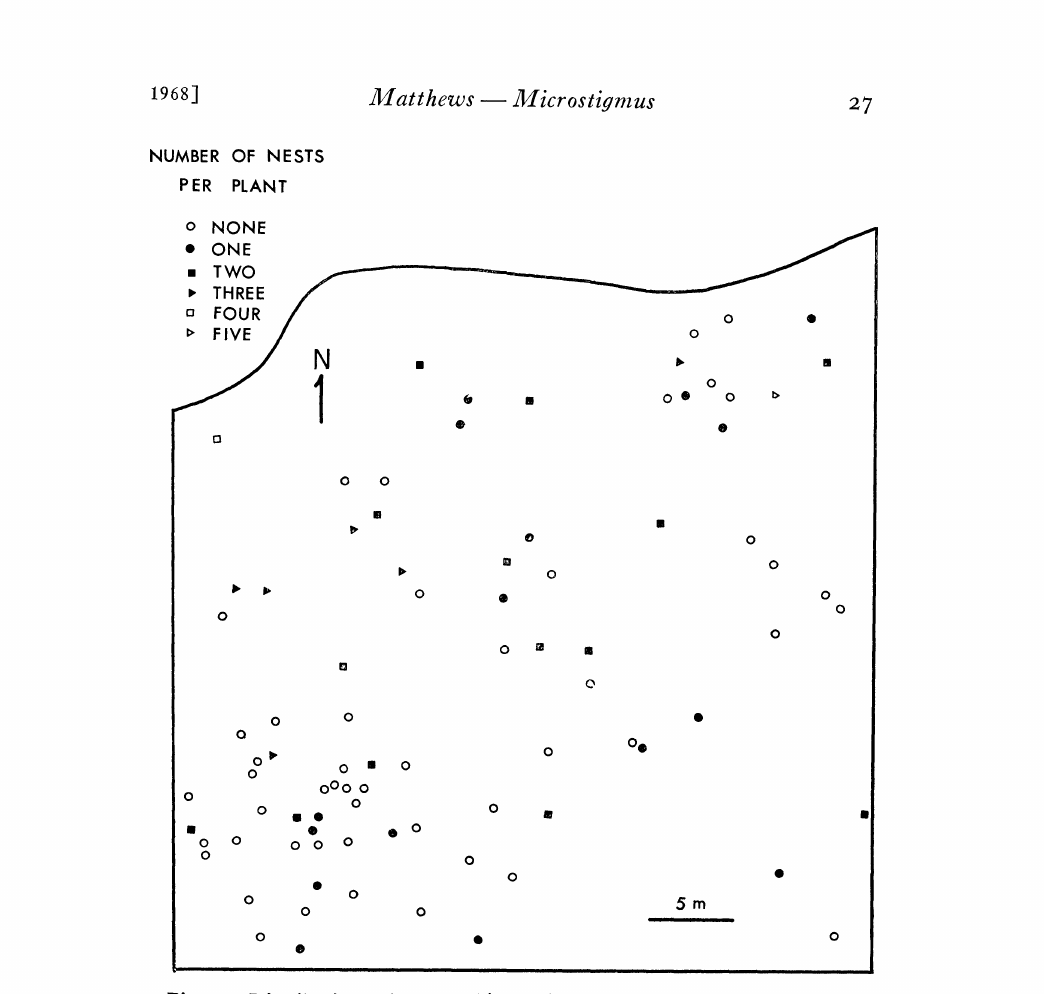
Fig. 2. Distribution of Crysophila palms and M. comes nests in the study plot near Rinc6n, Costa Riea. Each symbol represents a single Crysophila